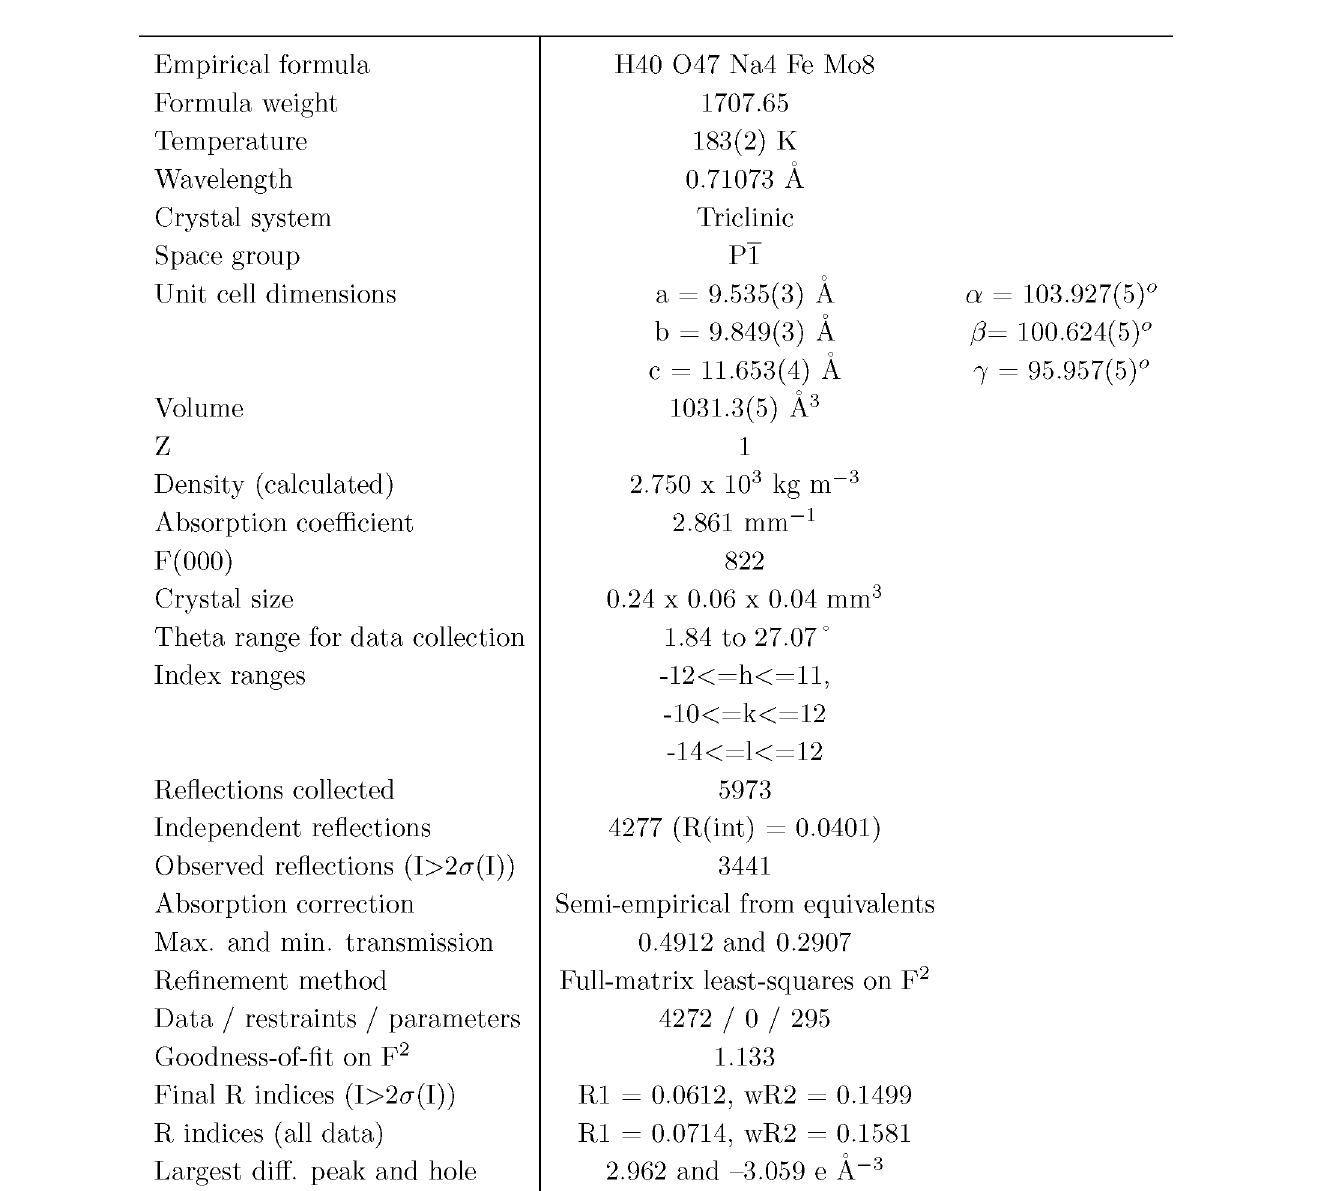
Table 1 Crystal data and structure refinement for the Na4Fe(H20)4Mo8027.16H20 polyox- ometalate cluster with infinite